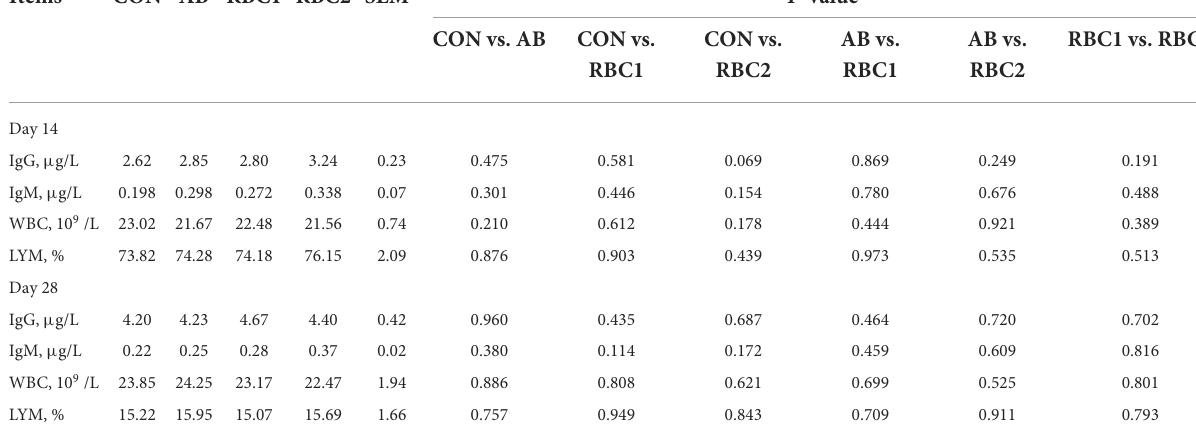
TABLE 6 Effect of RBC and AB supplementation on the blood profiles of weaning